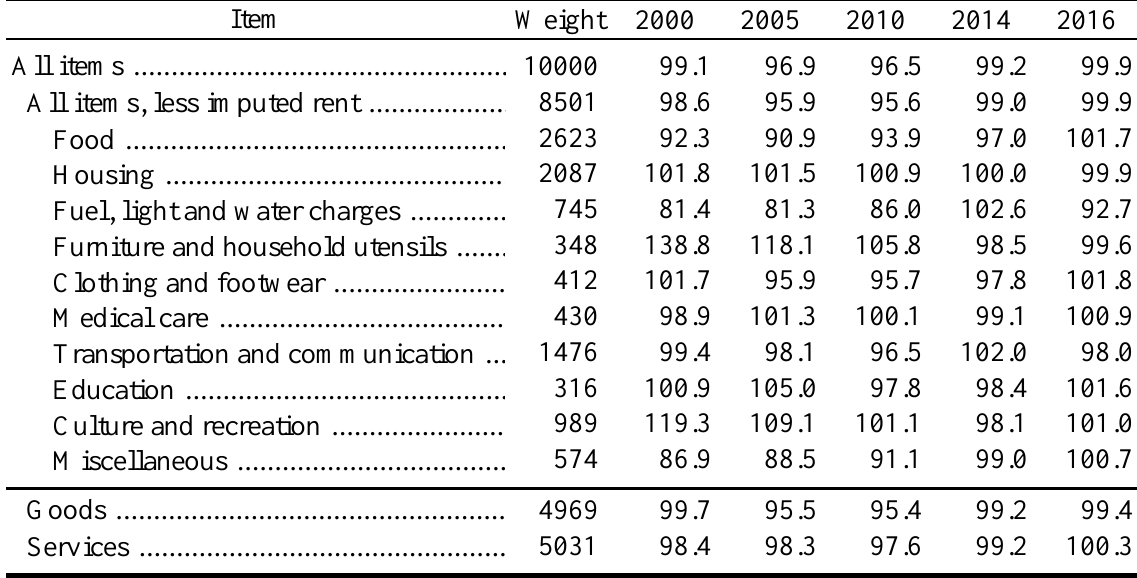
Source: Statistics Bureau,